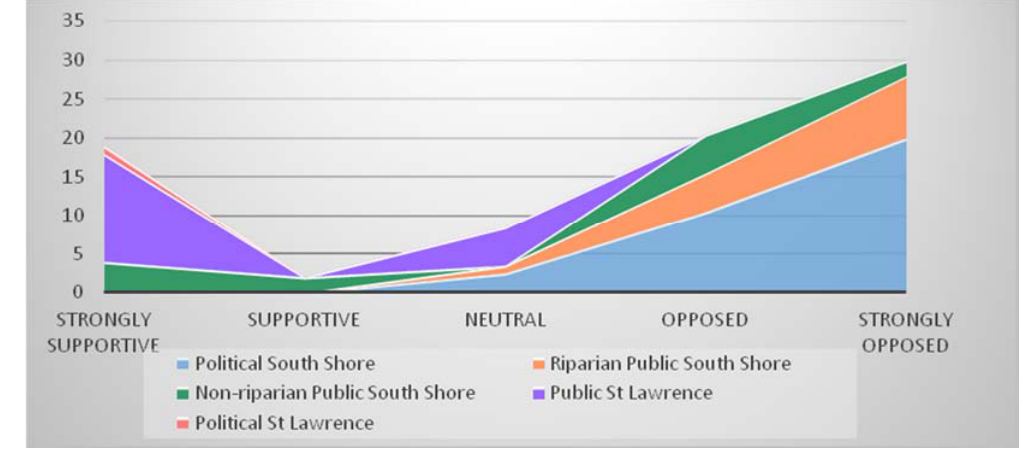
Figure 3. 2013 position of the public on Plan 2014. Table 3. Evidence of assigned position of stakeholders (excluding the general public) towards Plan 2014.